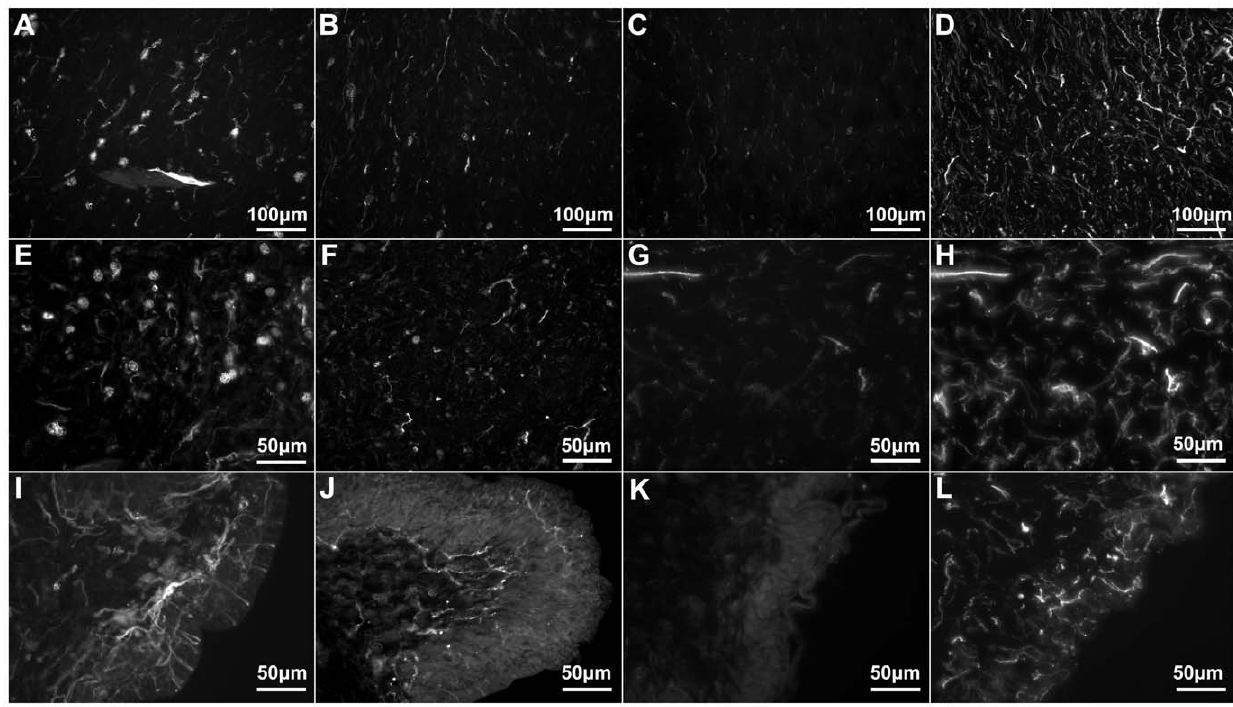
Figure 3. Anti-calbindin 1, anti-parvalbumin, and anti-calbindin 2 immunoreactivity in the body wall nervous system of Holothuria glaberrima (Holothuroidea). Longitudinal sections through the body wall showing immunoreactivity to anti-calbindin 1 (A,E,I), anti-parvalbumin (B,F,J), and anti-calbindin 2 (C,G,K) as compared to RN1 (D,H,L) immunoreactivity in the different layers of the body wall. Immunoreactivity of the internal connective tissue plexus (A–D), external connective tissue (E–H) and epidermis (I–L) showed that the anti-CBP only labeled a minor subpopulation of fibers and cells within these plexi, as compared to RN1 which labeled a large subpopulations of cells and fibers of the body wall nervous